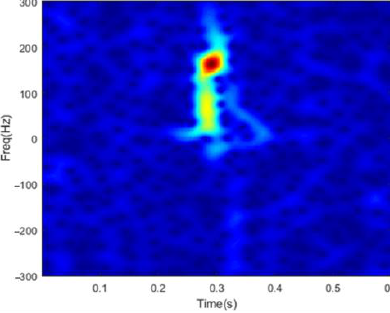
Figure 1. An example spectrogram.